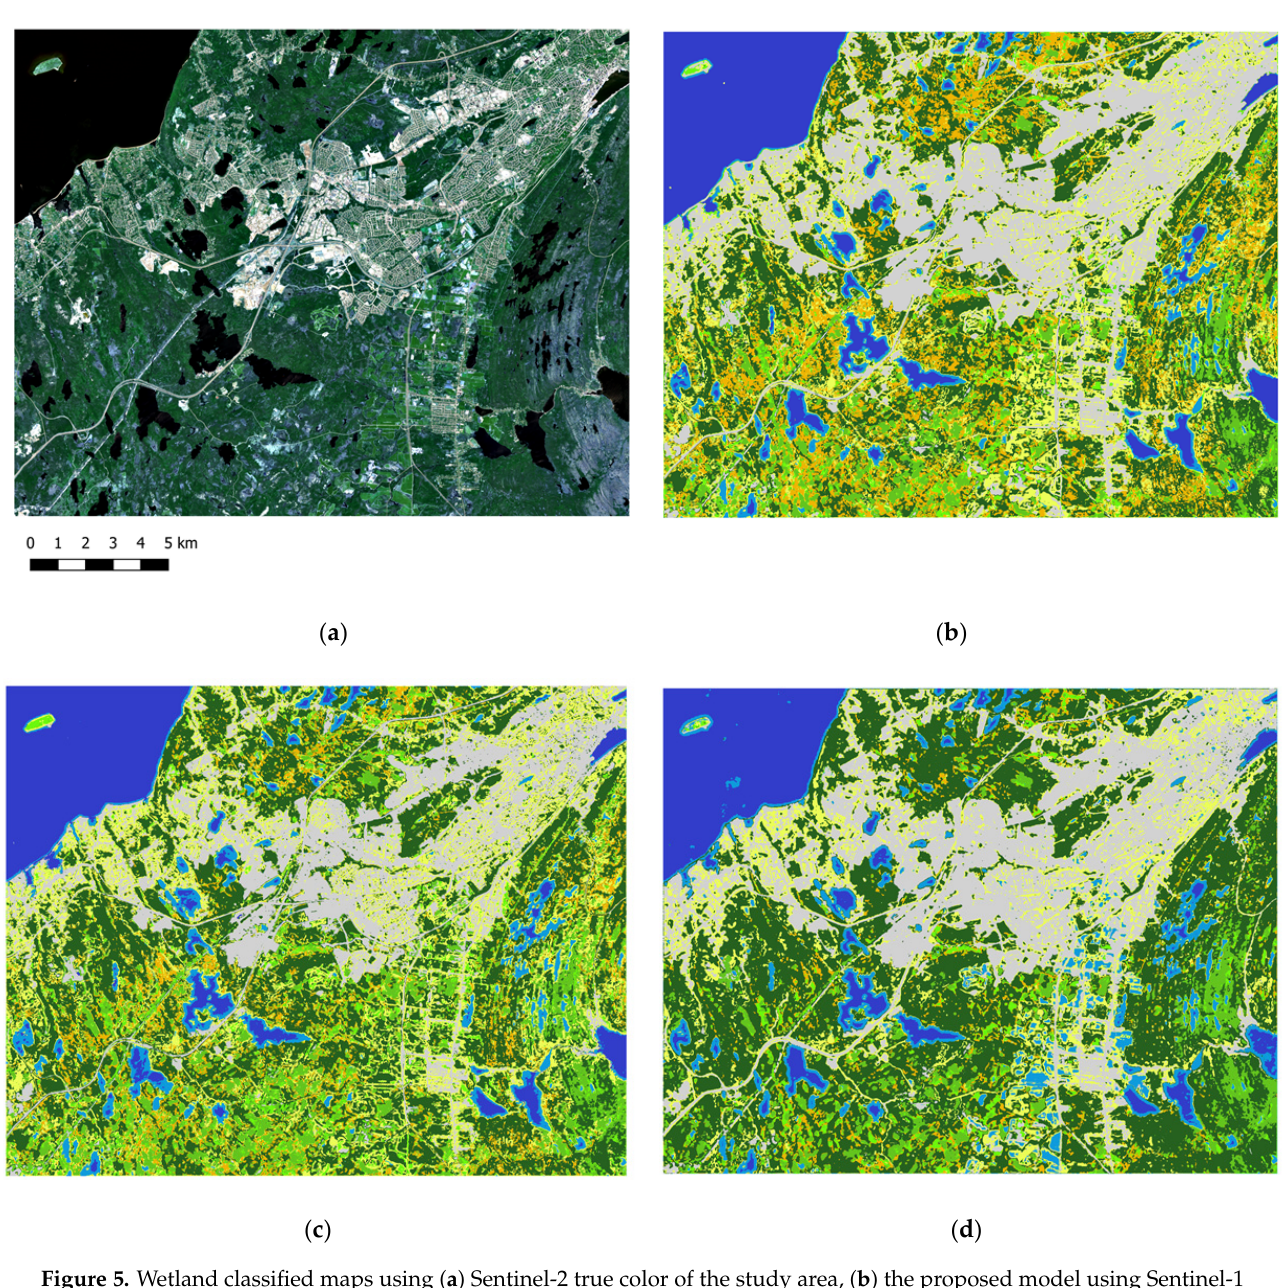
Figure 5. Wetland classified maps using ( a ) Sentinel-2 true color of the study area, ( b ) the proposed model using Sentinel-1 and Sentinel-2 features, ( c ) the proposed model using only Sentinel-2 data, and ( d ) the original AlexNet CNN network.